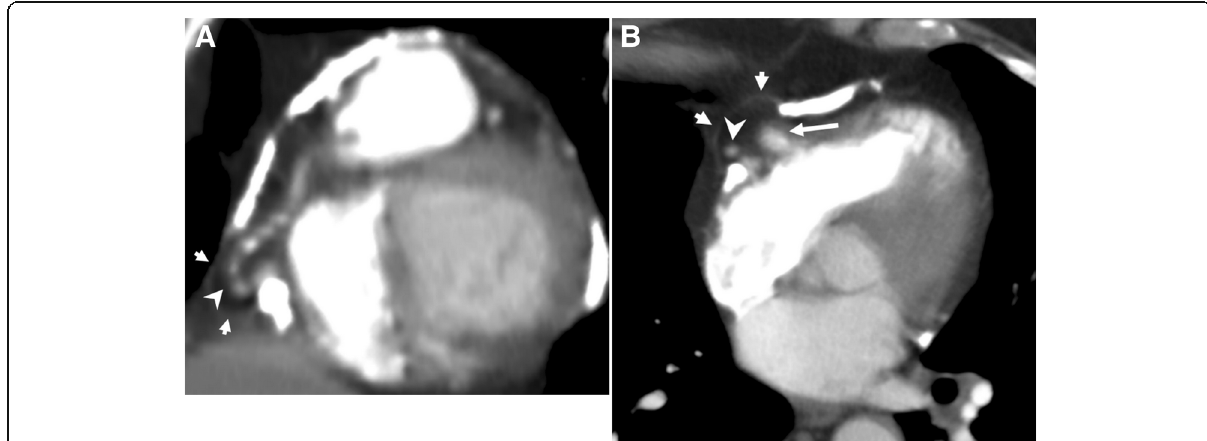
Fig. 12 62-year-old woman with echocardiography findings suggestive of restrictive cardiomyopathy or constrictive pericarditis. Contrast-